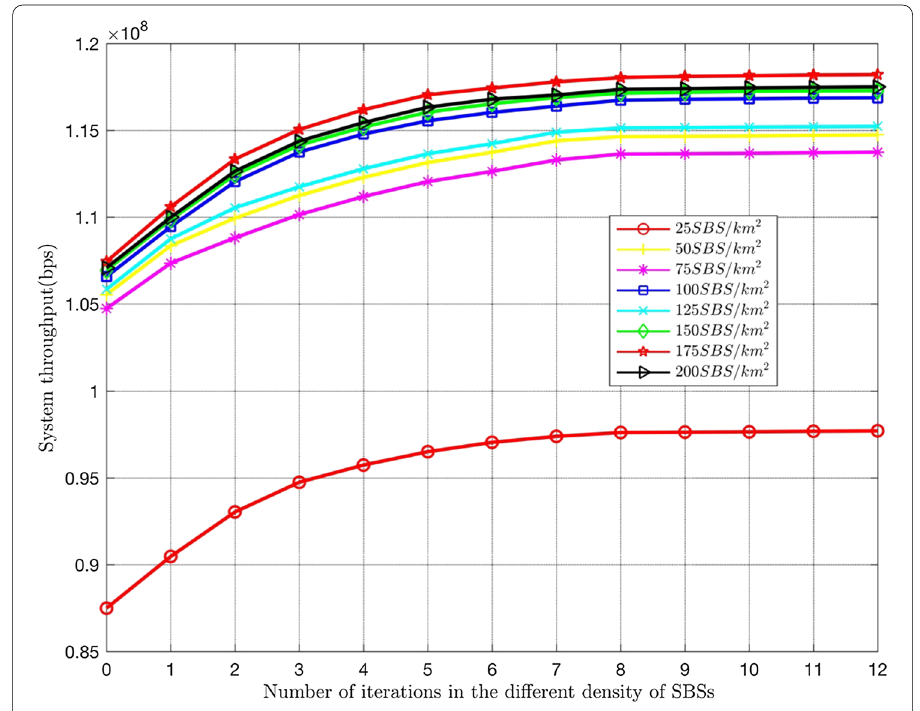
Fig. 14 The system throughput evolution in different density of SBSs